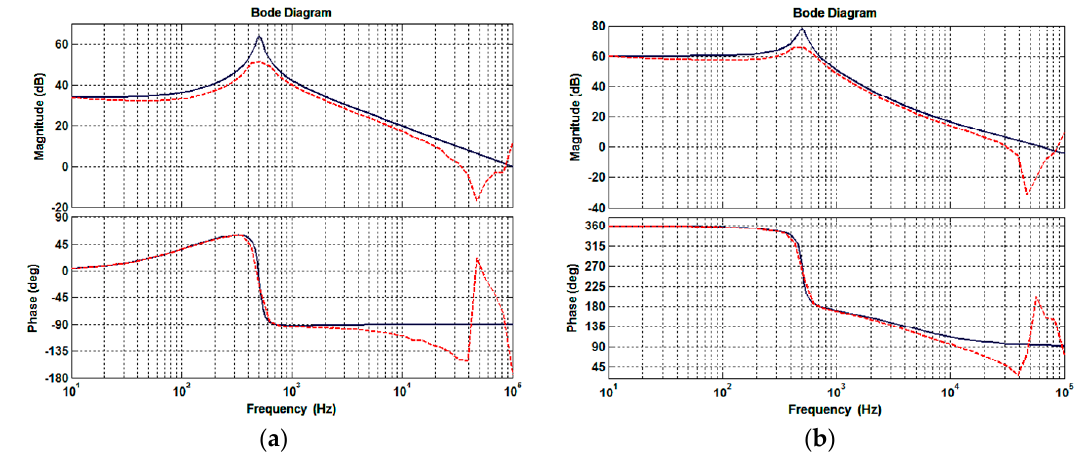
Figure 13 . Comparison of frequency responses of the proposed model (black solid lines) and detailed circuit model (red dashed lines): ( a ) Bode diagram of G id ( s ); ( b ) Bode diagram of G ud ( s ).